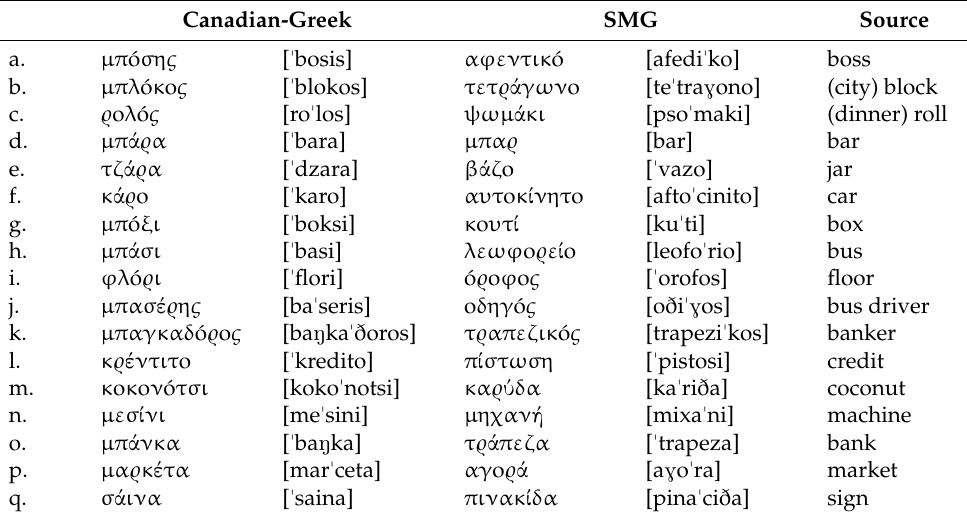
Table 8. Loanwords in the speech of